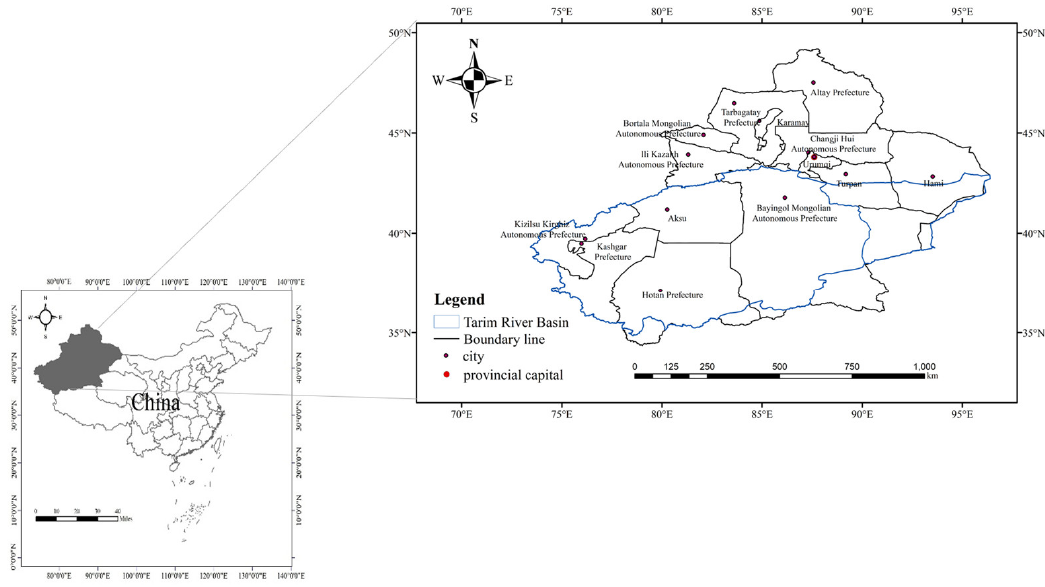
Figure 4. Schematic diagram of Xinjiang and TRB.